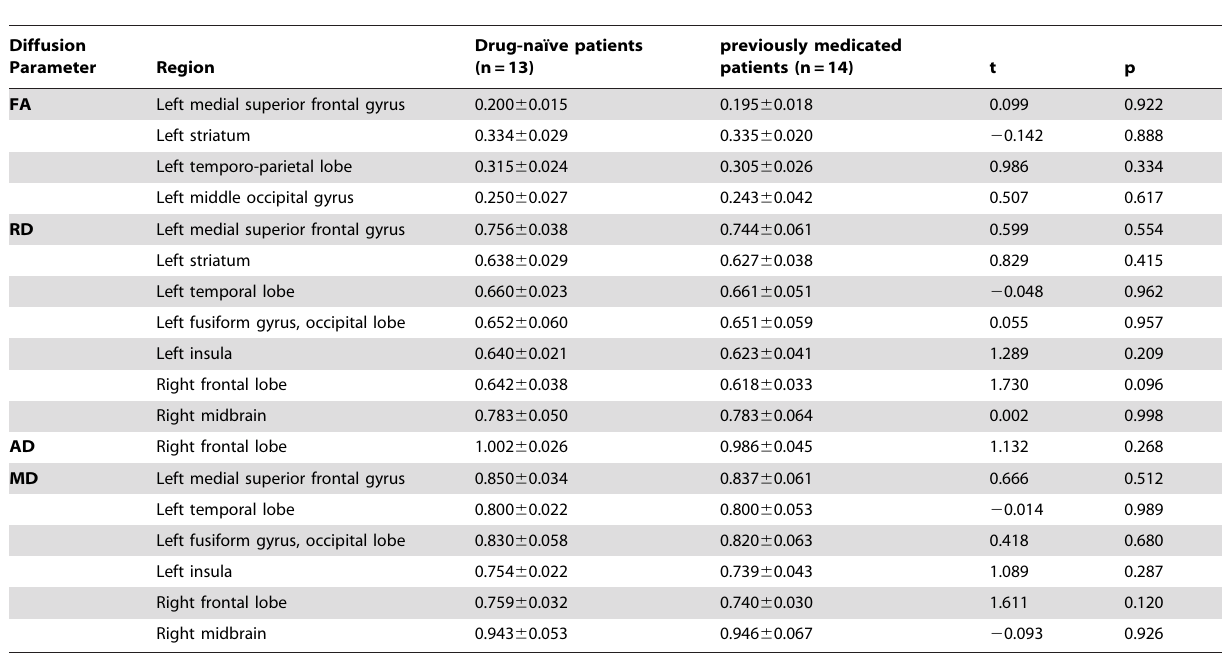
Table 3. Mean FA, RD, AD and MD values between drug-naive and previously medicated OCD patients.